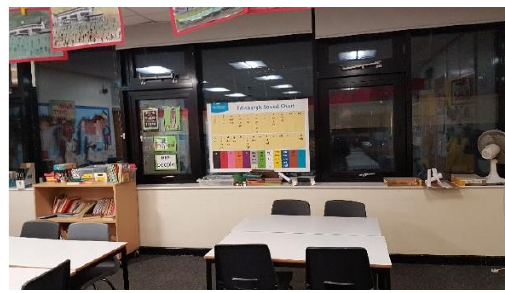
Figure 7. Picture of classroom B3.